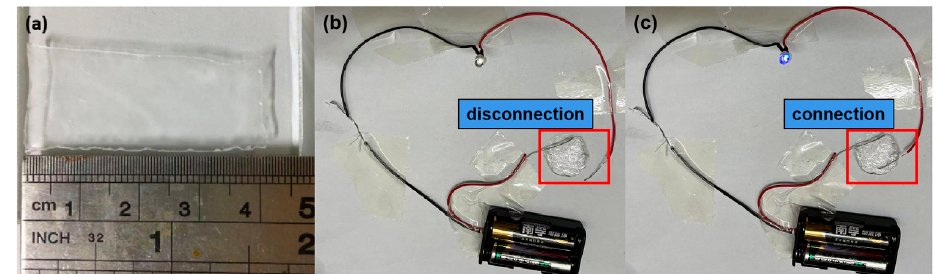
Figure 3. ( a ) Image of the P(BHMP-AM)-Zn 2+ hydrogel, and ( b , c ) image of the conductivity test.